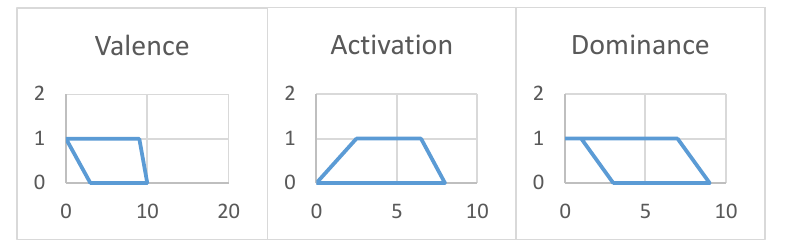
Fig. 14. The FOU of Anuri (Glad) for dimensions valence, activation and